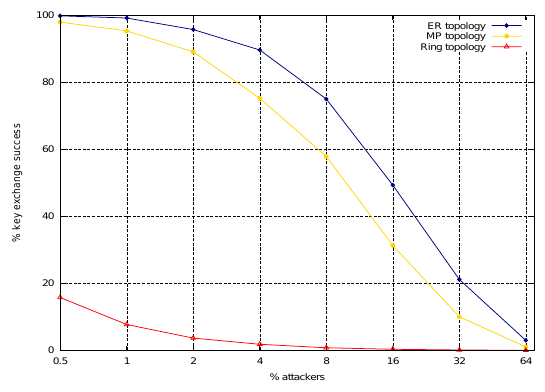
Figure 6. Success rate of the key exchanges for different network